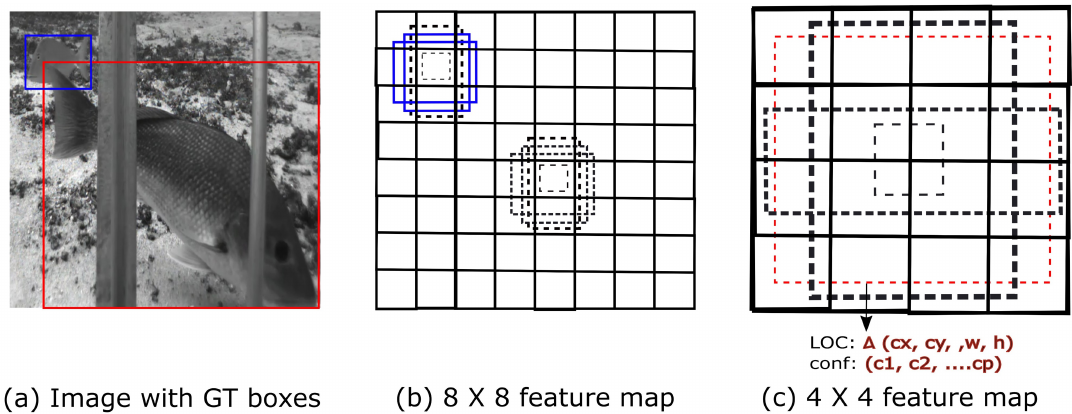
Figure 2. Overview of SSD detection [37]. ( a ) SSD takes an input image and ground truth boxes for each object during training. In a convolutional fashion, at each location, different small sets (e.g., 4) of default boxes of different aspect ratios in several feature maps with different scales (e.g., 8 × 8 and 4 × 4 in ( b , c )) are evaluated. For each default box, the shape offsets and the confidences for all object categories (( c 1 , c 2 , . . ., c p )) are predicted; c x , c y , w , and h refer to the x center, y center, width, and height of the bounding box,